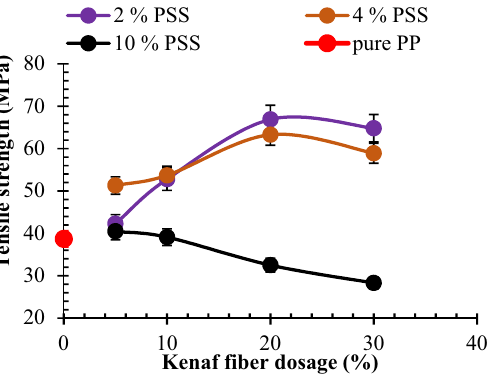
Figure 6. Graphical plot for the interaction between admix of kenaf fiber (KF)/particulate snail shell (PSS) at varying proportion for the Tensile